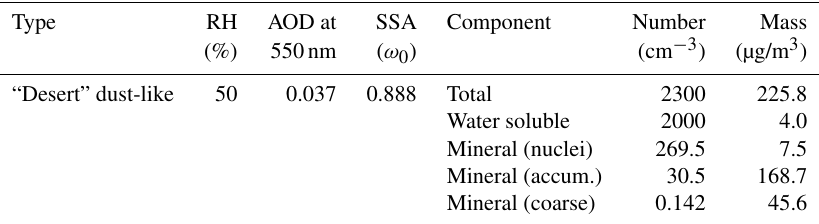
Table A1. Aerosol optical depth, single scattering albedo, and composition of the mineral dust for a relative humidity of